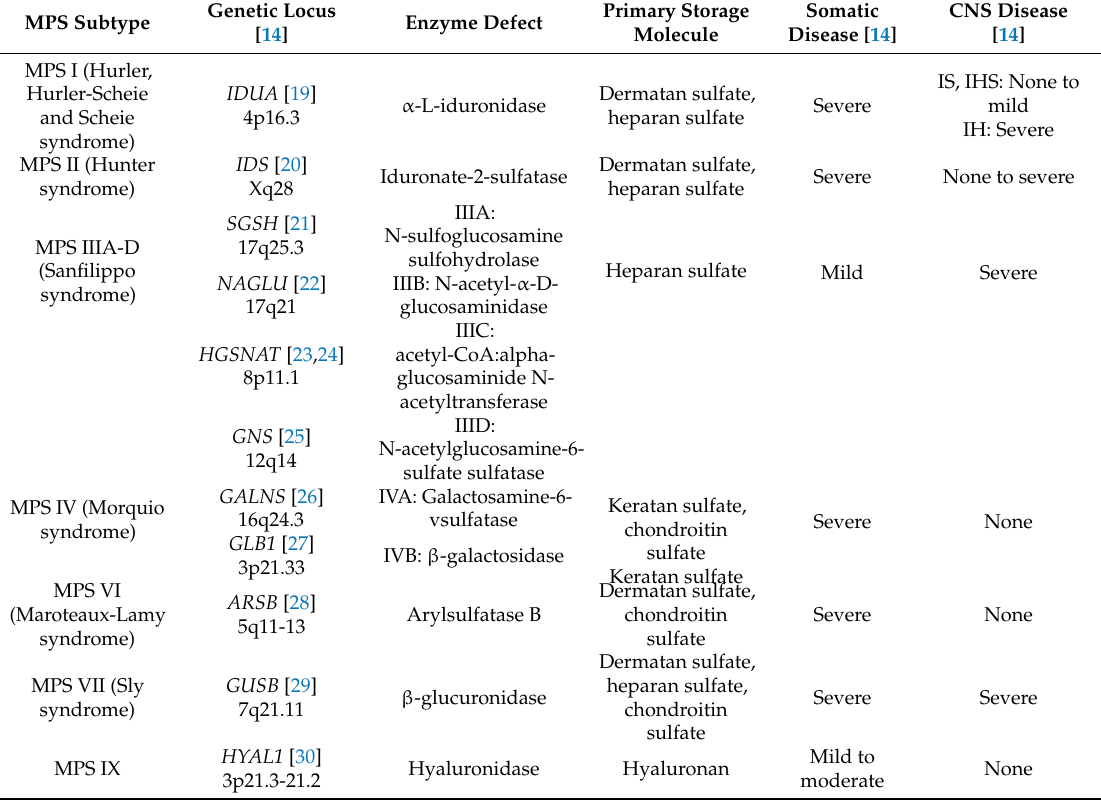
Table 1. Subtypes of Mucopolysaccharidoses and their clinical